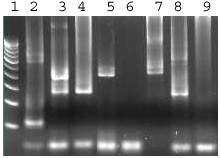
Agarose gel analysis of the product from RT-PCR followed by second-round nested PCR of RNA samples. From left to right, lane 1: 100 bp molecular marker, lane 2: sample positive for DEN-2 (119 bp), lane 3: sample with concurrent infection of DEN-3 and DEN-4, lane 4: sample positive for DEN-3 (290 bp), lane 5: sample positive for DEN-4 (392 bp), lane 6: negative sample, lane 7: sample positive for DEN-4 (392 bp), lane 8: sample positive for DEN-3 (290 bp) and lane 9: negative control.